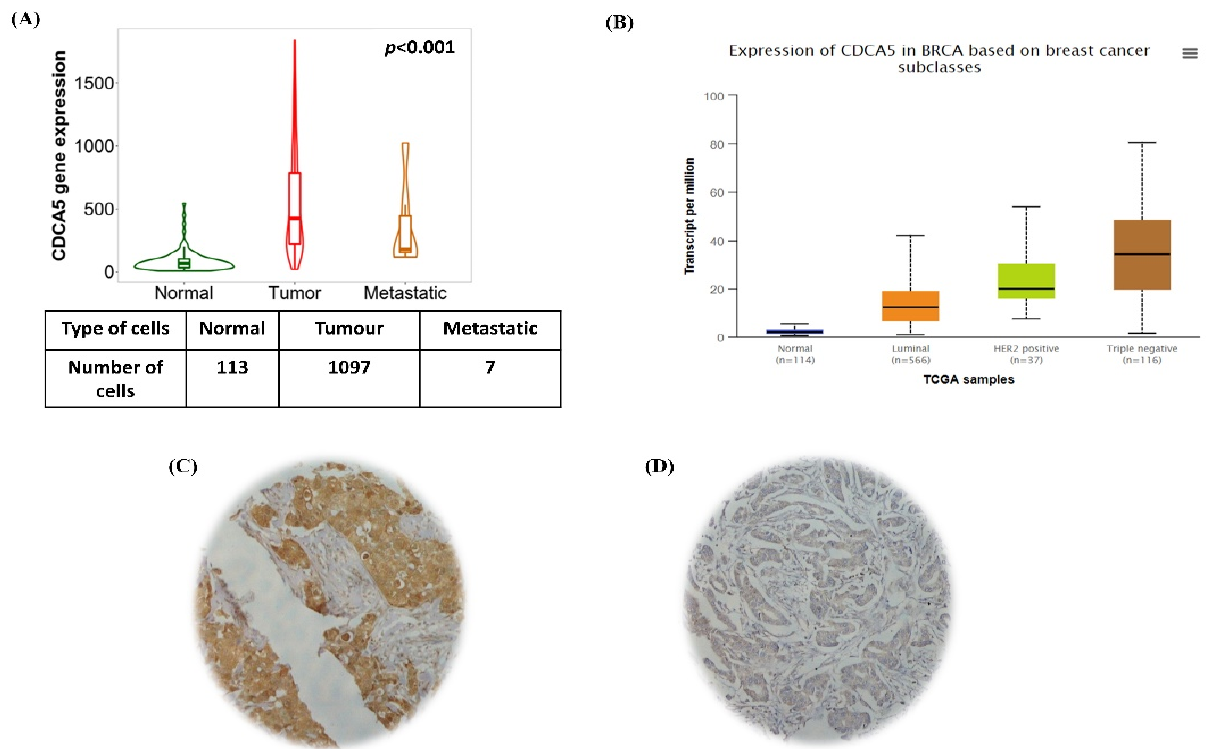
Figure 1. Distribution of mRNA and immunohistochemical expression of CDCA5 in BC. ( A ) RNA seq dataset comprising 1097 breast tumoral samples, 113 adjunct normal tissue and 7 metastatic samples were analyzed to evaluate CDCA5 expression using TNM data portal. ( B ) Evaluation of CDCA5 expression using PAM50 classification for BC obtained from UALCAN data portal. Repre- sentative immunohistochemical CDCA5 protein expression in invasive BC cores (power 20x). ( C )